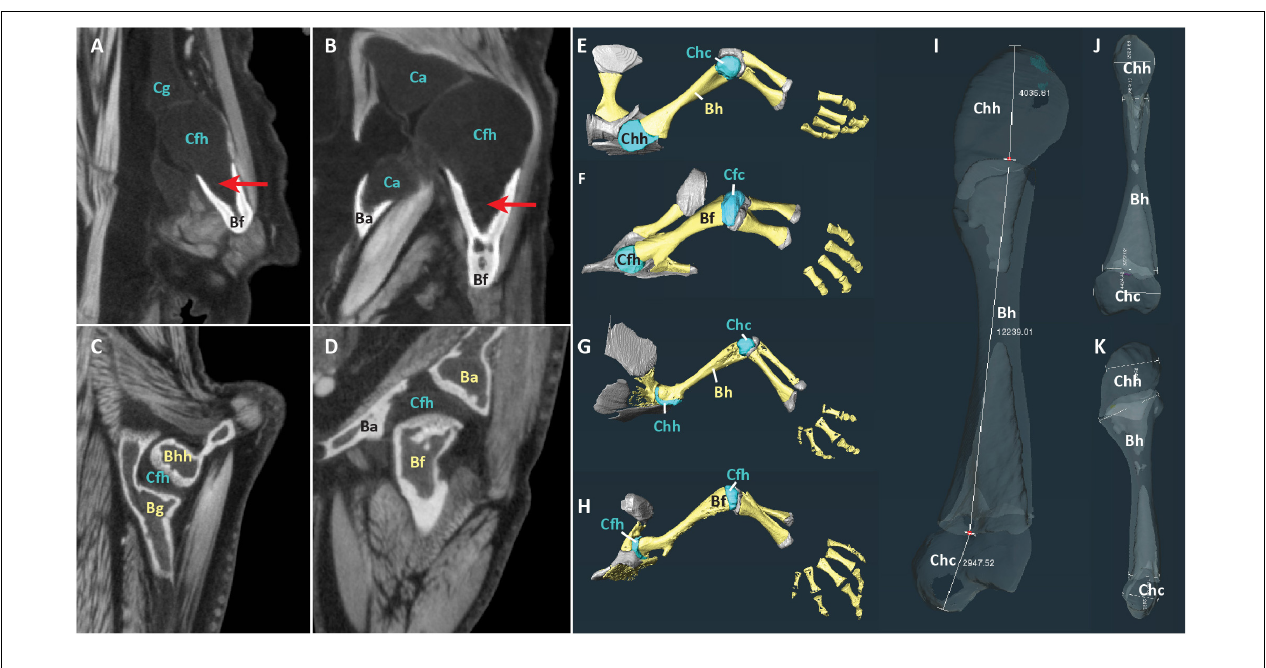
FIGURE 1 | Scans of representative aquatic and terrestrial salamanders showing morphological differences and measurement methods. (A–D) DiceCT slices through shoulder (A) and hip (B) joints of the aquatic salamander Necturus maculatus and the shoulder (C) and hip (D) joints of the terrestrial salamander Pseudotriton ruber . Red arrows show cartilage cones within bony shaft. (E–H) 3-D surfaces of bones (yellow) and cartilages (blue and gray) in the forelimb of N. maculatus (E) , the hindlimb of N. maculatus (F) , the forelimb of P. ruber (G) , and the hindlimb of P. ruber (H) (carpals not shown). (I–K) Humerus of N. maculatus showing linear measurements in µ m of cartilage thickness and bony shaft (I) and the long and short axes of the mineralized and cartilaginous epiphyses (J,K) . Abbreviations: bony acetabulum (Ba), bony femoral shaft (Bf), bony glenoid (Bg), bony humeral shaft (Bh), cartilaginous acetabulum (Ca), cartilaginous femoral condyles (Cfc), cartilaginous femoral head (Cfh), cartilaginous glenoid (Cg), cartilaginous humeral condyles (Chc), cartilaginous humeral head